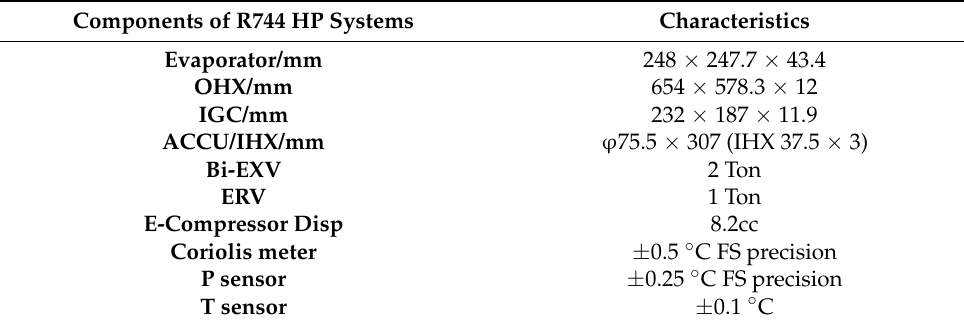
Table 1. Key characteristics of the components in the test